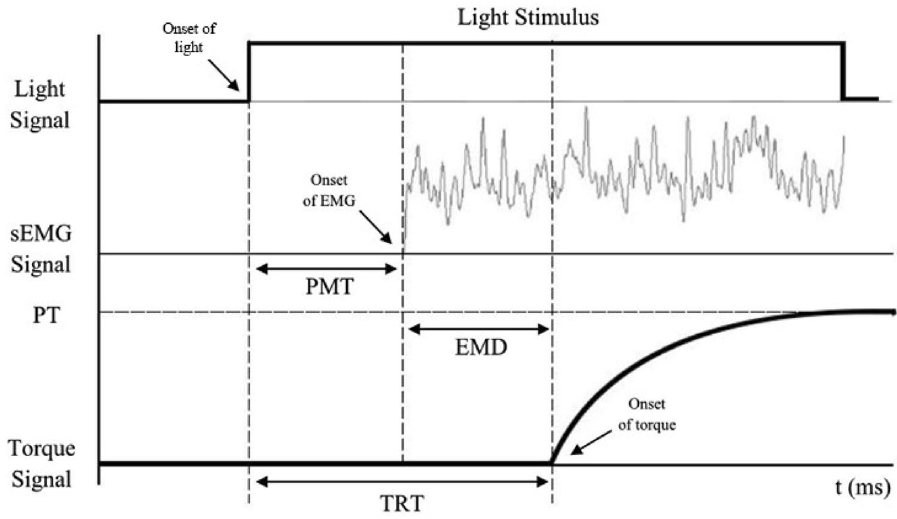
Figure 3. Schematic representation of TRT determination during an unanticipated trial. TRT—total reaction time, PMT—premotor time, EMD—electromechanical delay, PT—peak